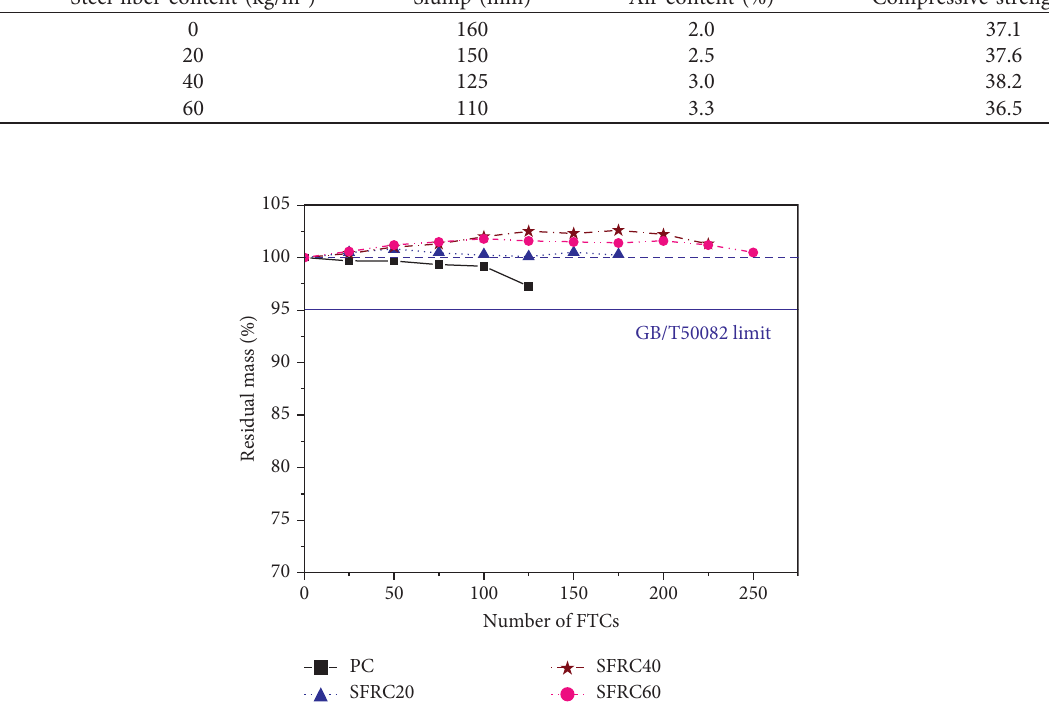
Figure 2: Variation of the ML of different samples during FTCs.